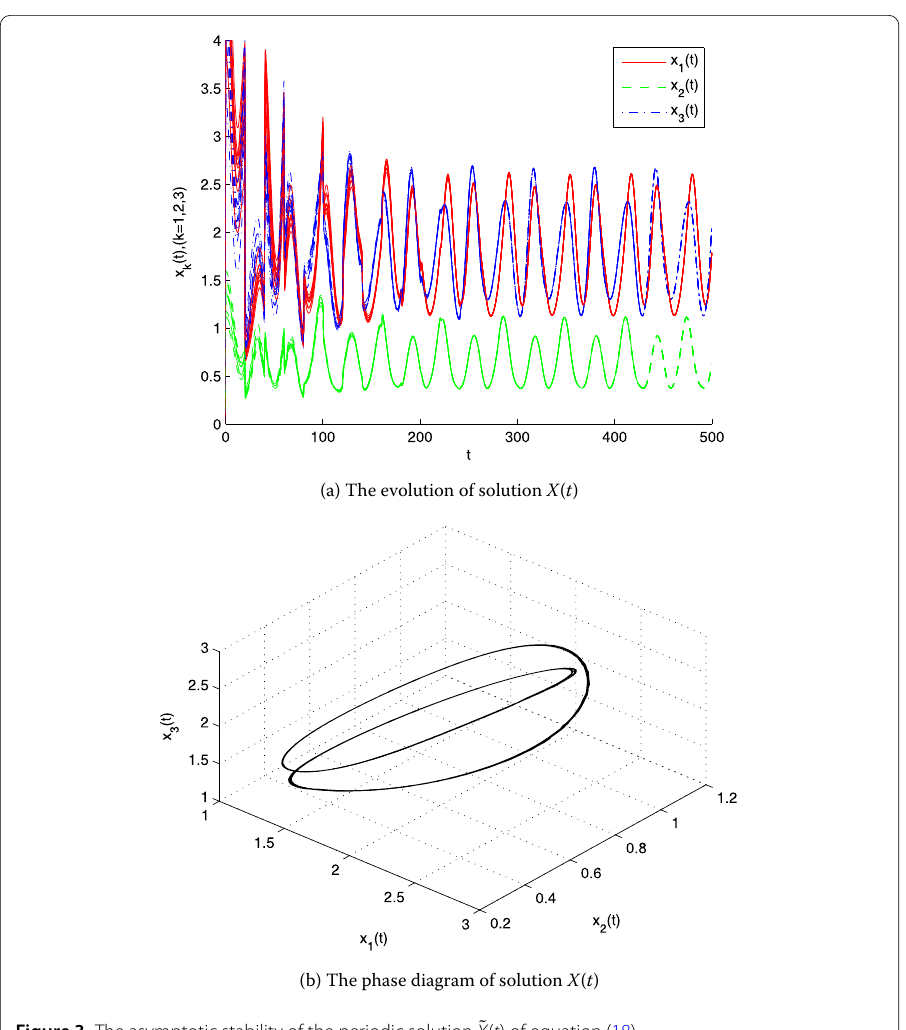
Figure 3 The asymptotic stability of the periodic solution ˜ X ( t ) of equation